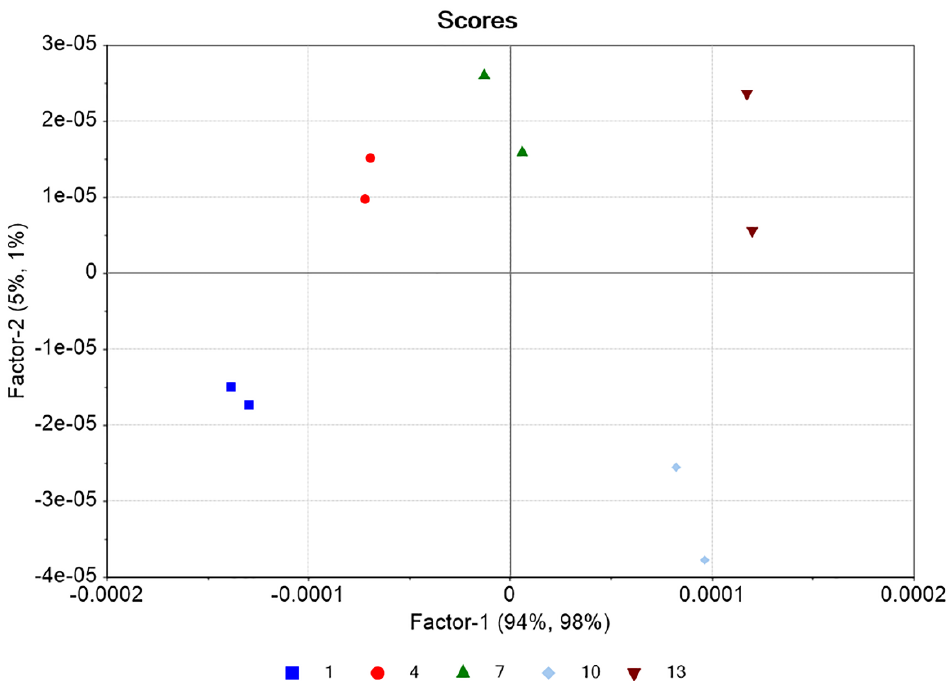
Figure 5. Leave-one-out CV results (blue: training set, red: validation set).